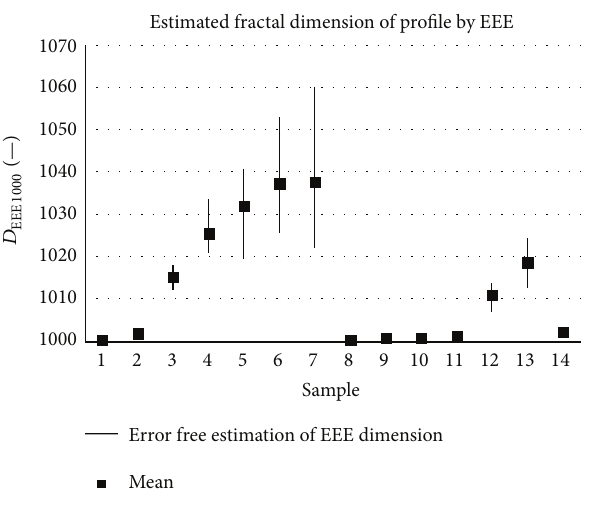
Figure 11: Results of fractal dimension estimation, 𝐷 𝐸𝐸𝐸1000 ( 𝑥 -